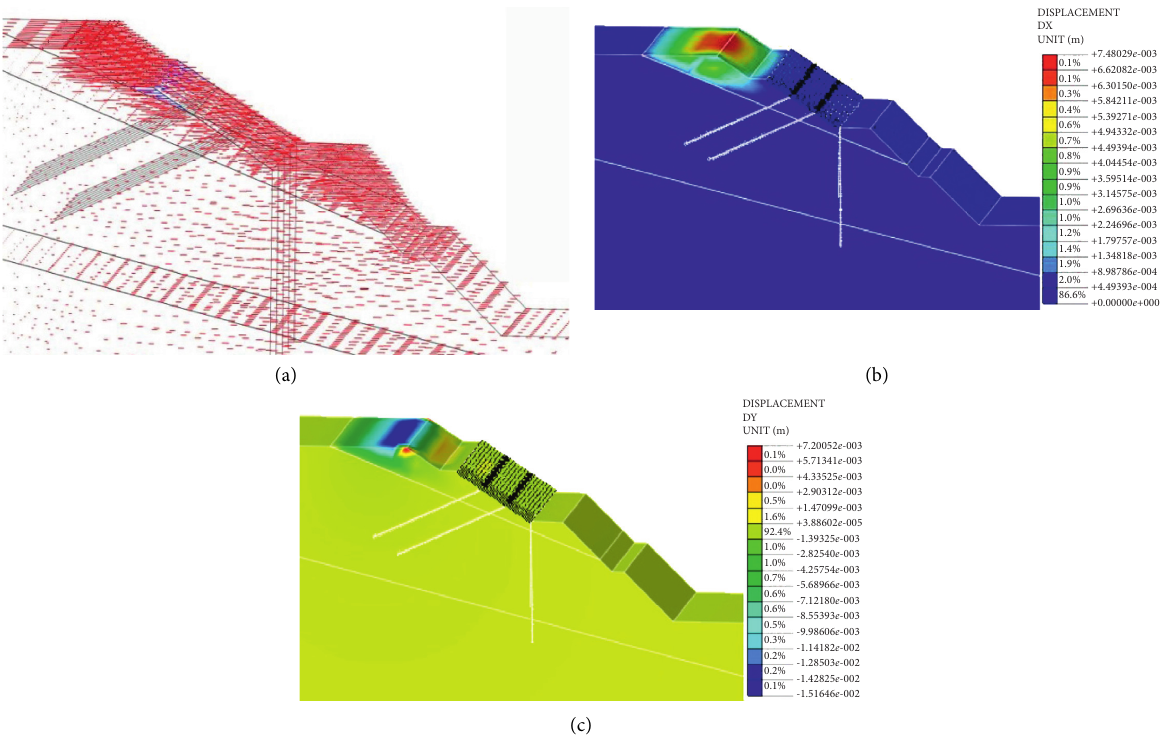
Figure 7: Characteristics of horizontal displacement and settlement of slope. (a) Displacement vector picture. (b) Horizontal displacement cloud picture. (c) Settlement cloud